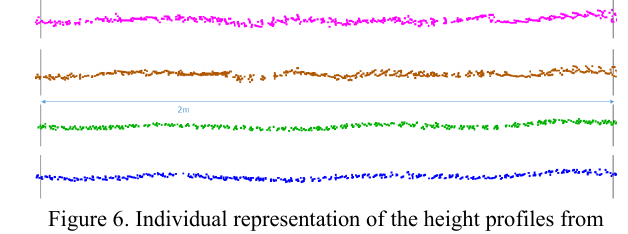
Figure 6. Individual representation of the height profiles from Figure 5 - P4D JPG80 (pink), P4D TIF (brown), PS JPG80 (green) and PS TIF